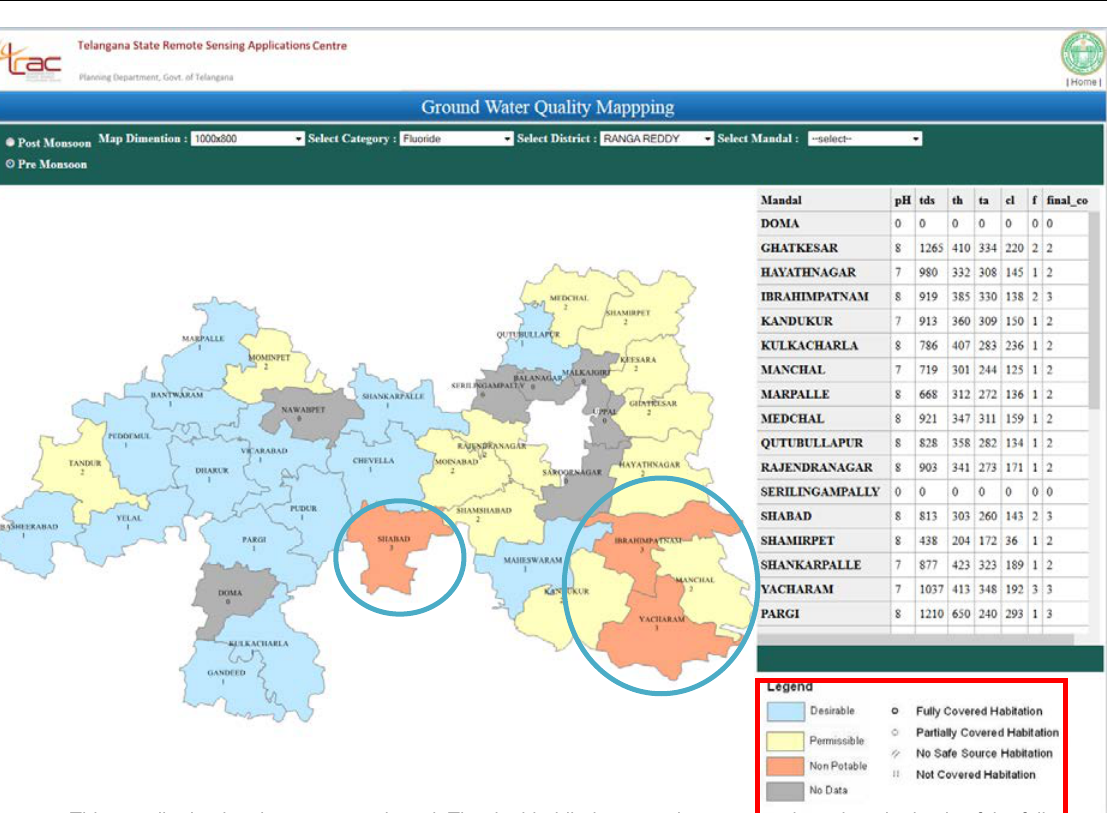
Figure 3: Web interface for Ground Water Quality Mapping